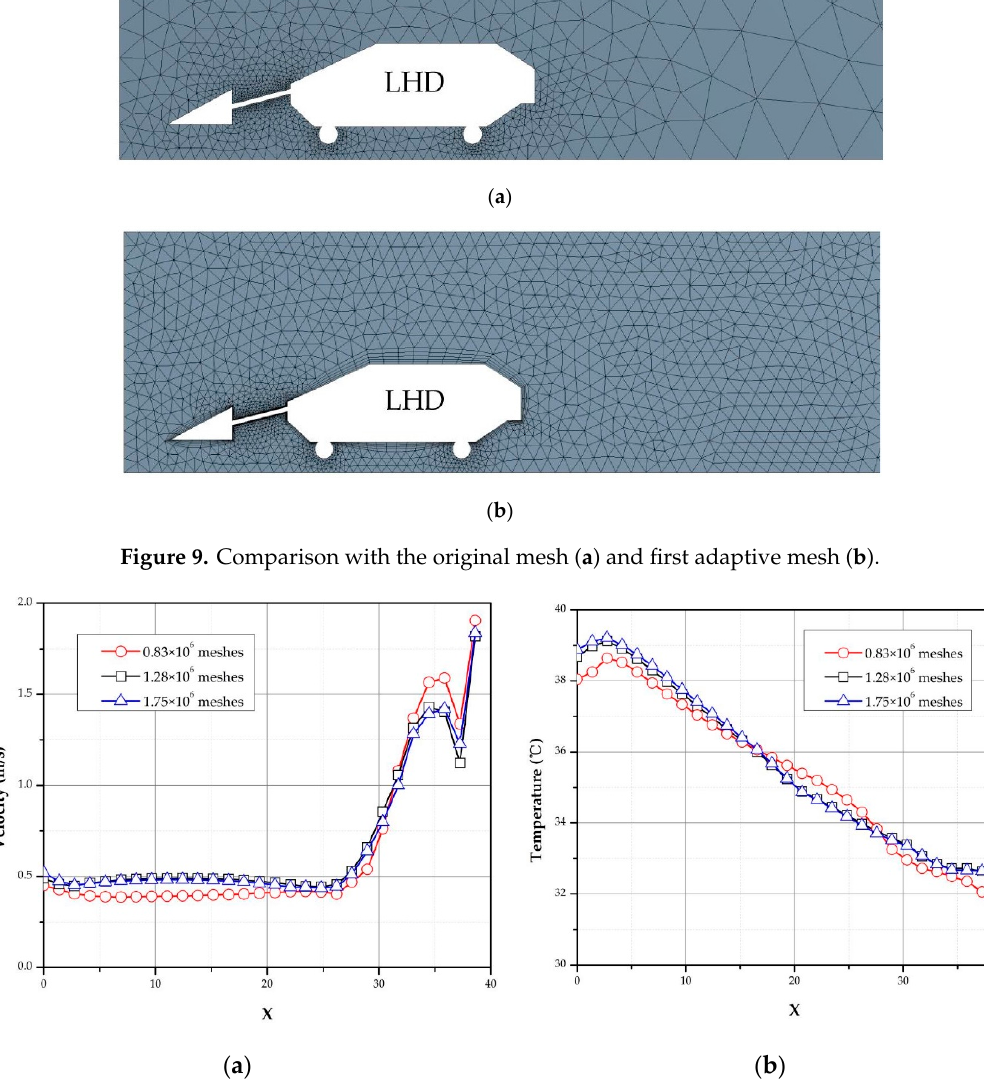
Figure 10. Airflow velocities and temperatures distribution of calculating three times along the airway. ( a ) Airflow velocities distribution; and ( b ) airflow temperatures distribution.